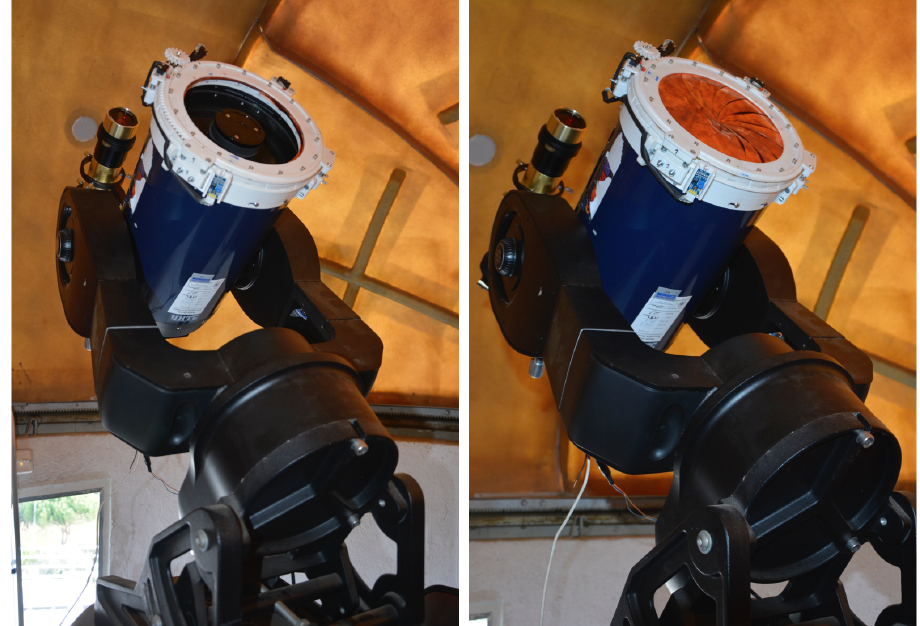
Figure 15. Final version of the smart cover mounted on the telescope. On the left : open. On the right :